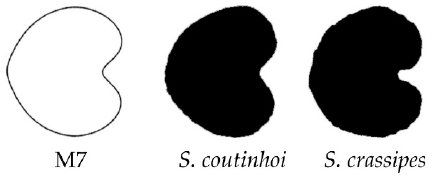
Figure 8. Model 7 with the average silhouette of S . coutinhoi and S . crassipes .